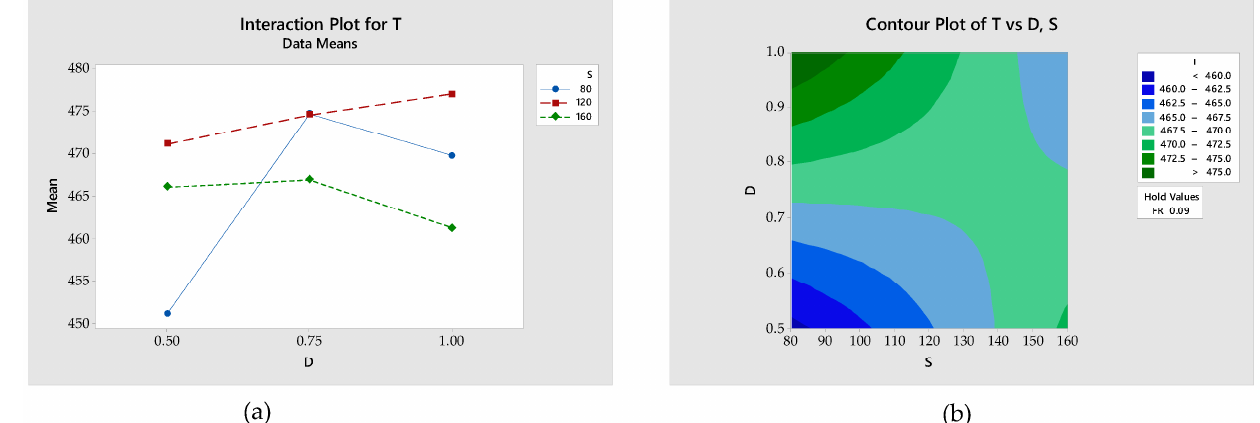
Figure 11. ( a ) Interaction plot and ( b ) contour plot for T using conventional edge. Table 7 summarizes the mathematical equations representing the measured outputs.